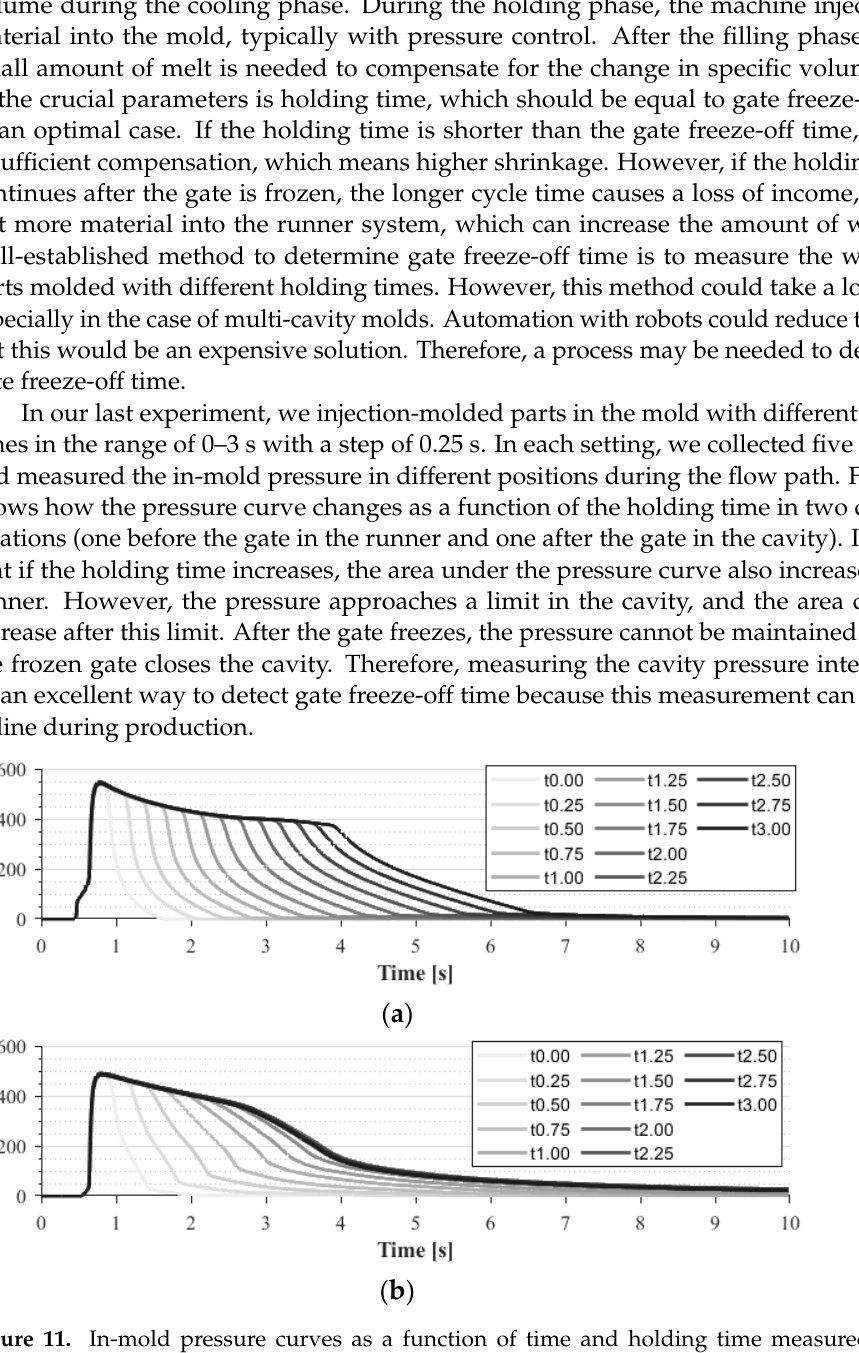
Figure 10. Effect of melt temperature and injection rate on the ratio of the longest and shortest melt arrival times: ( a ) cavity 03–07; ( b ) cavity 04–08.